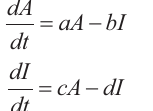
FIGURE 2 | Activator-inhibitor reaction as loss of structure and gain of